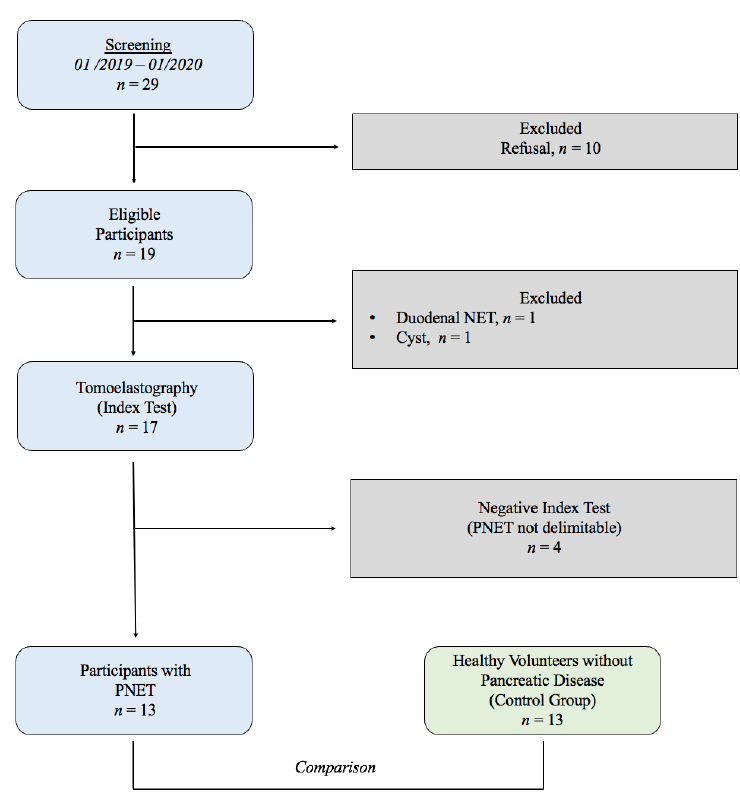
Figure A1. Study flowchart. PNET = pancreatic neuroendocrine tumor.